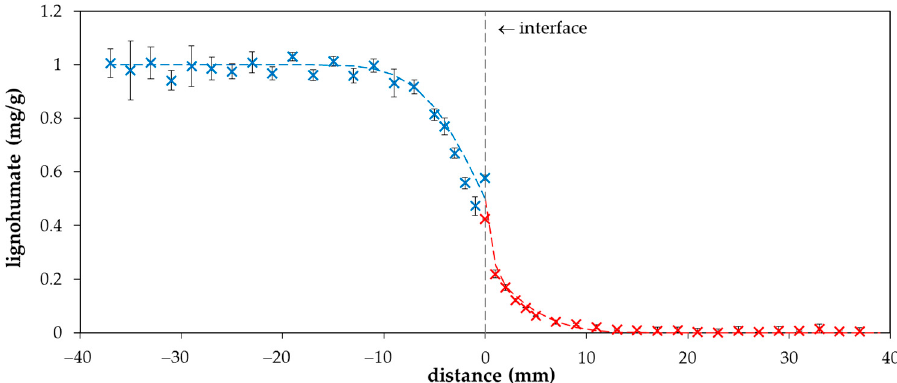
Figure 2. Concentration profile of lignohumate in agarose hydrogel after one day. The blue points belong to the donor hydrogel (distance x < 0), and the red points belong to the acceptor hydrogel (distance x > 0).